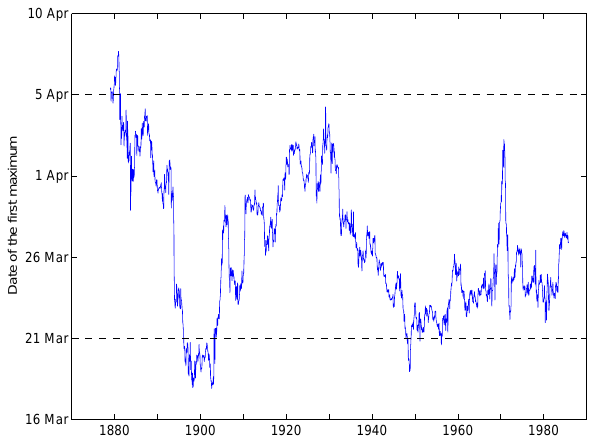
Fig. 3. Time variation of the phase of the aa -index semiannual variation, computed using a 22-year sliding window, centered. The phase is reckoned as the date of the first maximum.